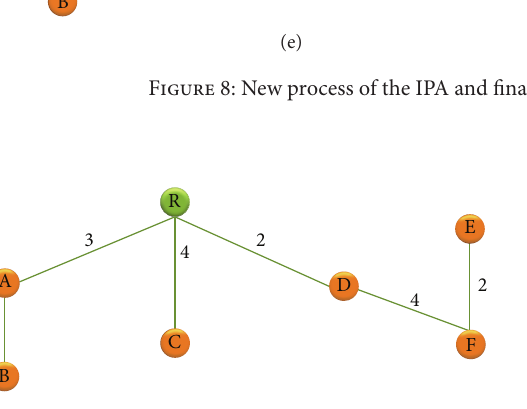
communication between different nodes with less energy consumption and lower memory space in the